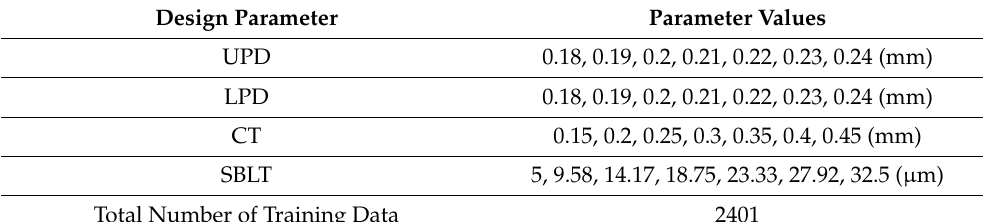
Table 9. Design parameters for 2401 training data.